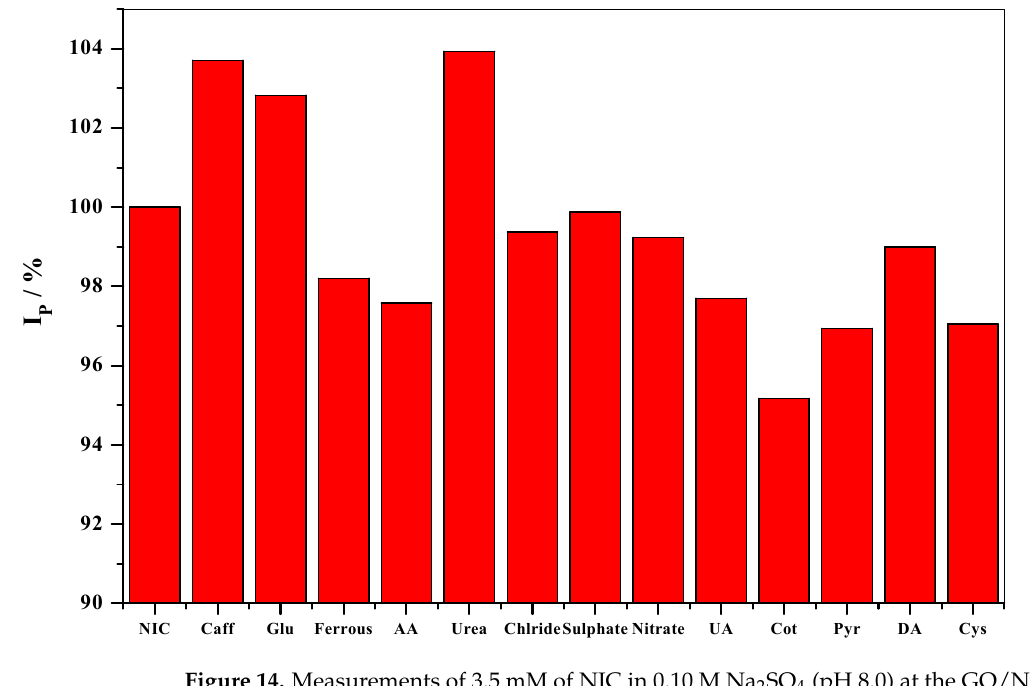
Figure 14. Measurements of 3.5 mM of NIC in 0.10 M Na 2 SO 4 (pH 8.0) at the GO/Nq/GCE in the presence of the tolerance limit of foreign species.